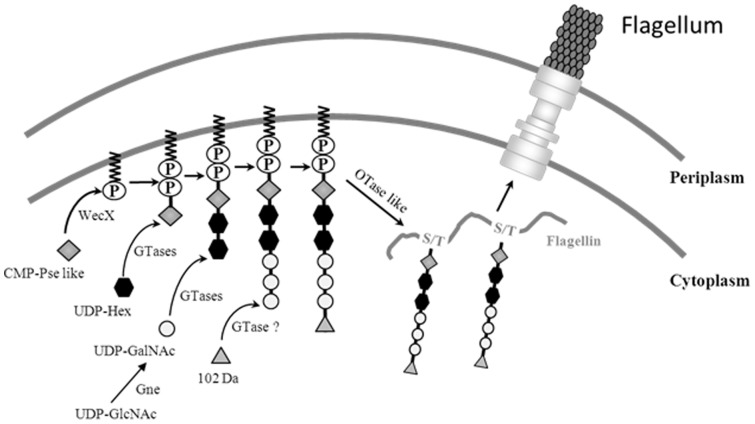
Molecular model proposed for the polar flagellum glycosylation.We suggest that WecX is able to link CMP-Pselike to Und-P, and several different glycosyltransferases are able to form sequentially the heptasaccharide linked to Und-P, being first the glycosyltransferases that add Hex (two of them), then the glycosyltransferases that add GalNAc or a derivate of it (three of them), and finally a putative transferase for the unknown glycan of 102 Da. Then an enzyme, that we named OTase like, transfers in O-glycosylation basis these heptasaccharide to the threonine/serine amino acids of the polar flagellin. Once the flagellins molecules are glycosylated could be transported to produce the polar flagellum. Gne is the enzyme that converts UDP-GlcNAc in UDP-GalNAc, and their lack jeopardizes the UDP-GalNAc formation.